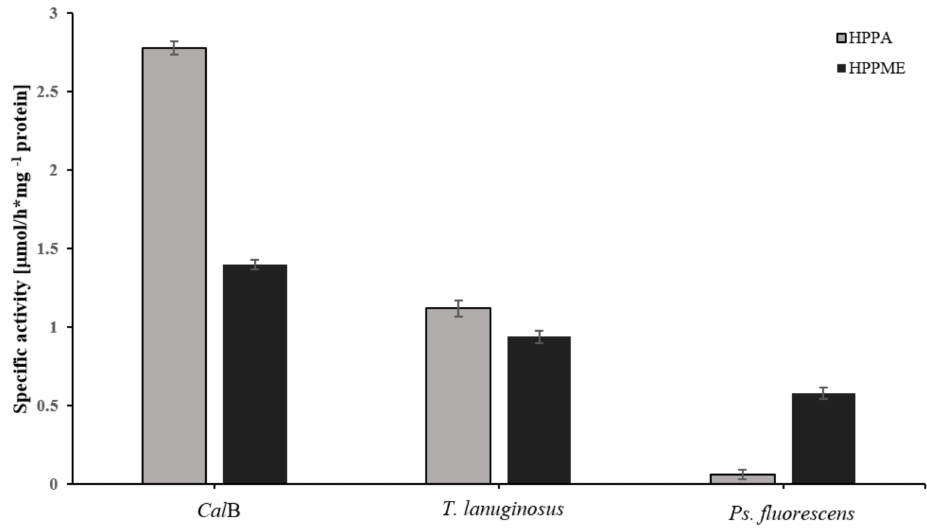
Figure 1. The esterification activities of C. antarctica B ( Cal B), T. lanuginosus and P. fluorescens lipases in the esterification of 3-(4-hydroxyphenyl) propionic acid (HPPA) and transesterification of methyl 3-(4-hydroxyphenyl) propionate (HPPME) with 1-octanol after a 3 h reaction